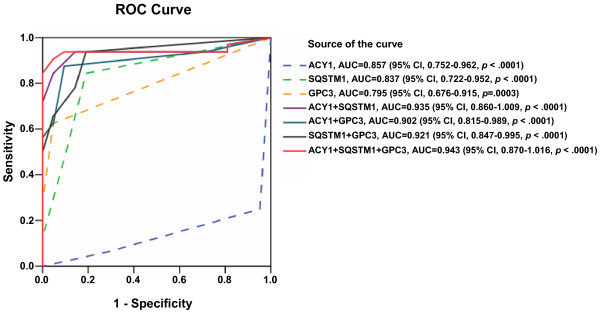
ROC curve analysis of individual markers and combinations of ACY1, SQSTM1, and GPC3 for discriminating between WDHCC and HGDN lesions. AUCs were 0.857 for ACY1, 0.837 for SQSTM1, 0.795 for GPC3, 0.935 for ACY1 + SQSTM1, 0.902 for ACY1 + GPC3, 0.921 for SQSTM1 + GPC3, 0.943 for ACY1 + SQSTM1 + GPC3.